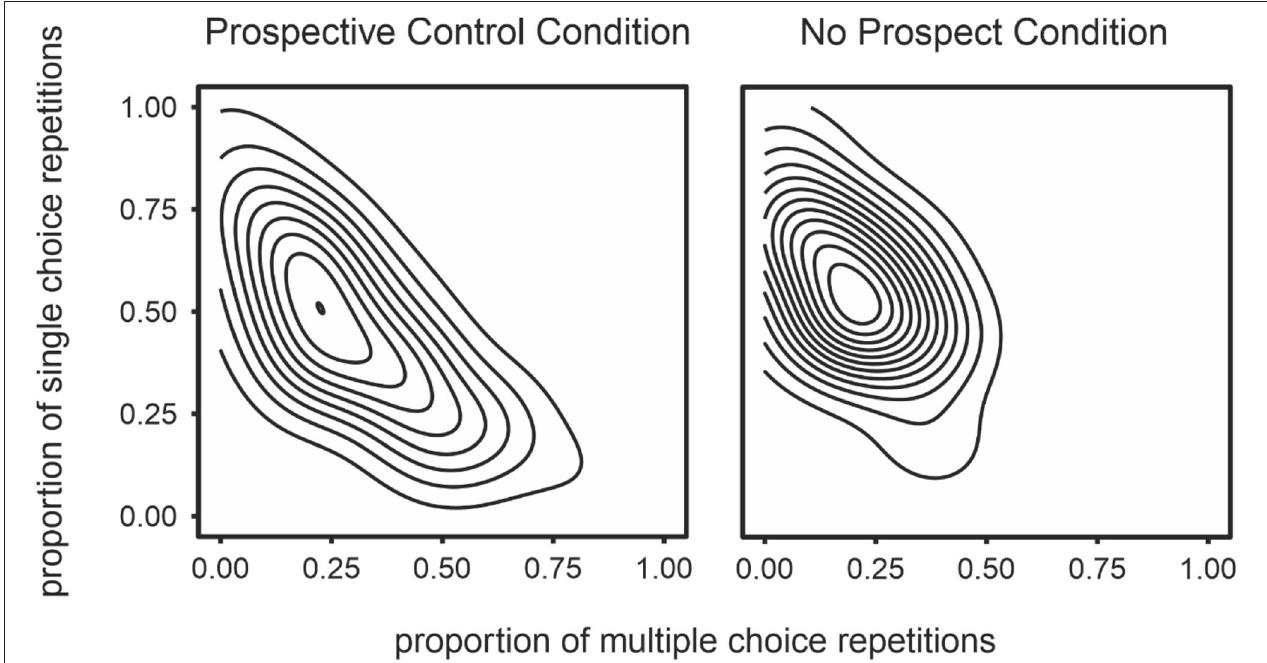
FIGURE 5 | Density plots representing exploration of strategy space in the prospective control (left) and no prospective control (right) conditions. The proportion of trials on which play involved complex strategies (alternations and sequences) are presented on the x-axis and the proportion of trials where a single choice was played repeatedly is presented on the y-axis. The density plot was generated by collapsing across all participants, for each condition separately. Regions with many concentric lines indicate a high density or frequency of that particular distribution of